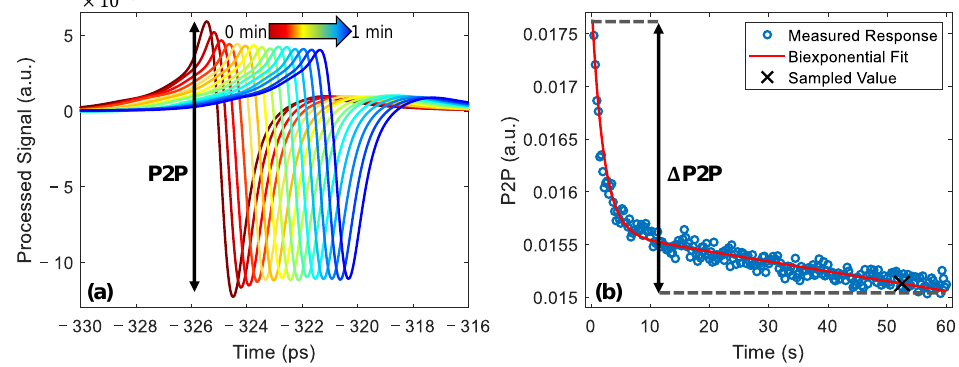
Figure 4. ( a ) The processed THz signals measured from the untreated skin of a single subject, the colour gradient shows increasing occlusion time. The pulses are plotted every second for the first three seconds then every five; they have been shifted horizontally for clarity. The definition of the peak-to-peak (P2P) variable is shown on the plot. ( b ) The P2P plotted as a function of occlusion time, fitted with a bi-exponential function shown by the red line and sampled 52 s into occlusion, as shown by the black cross. The definition of the Δ P2P variable is shown as the difference between the value of the fit at the start and end of occlusion.